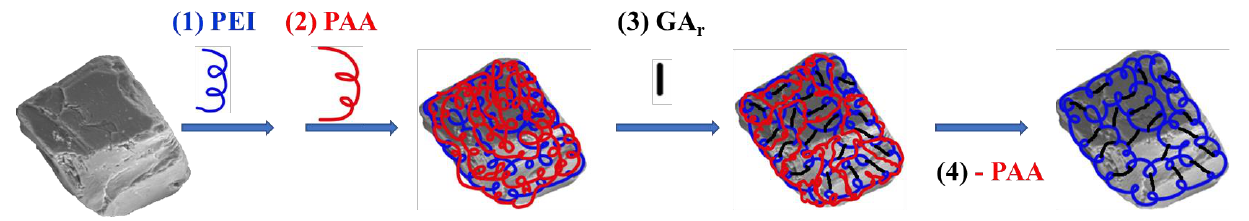
Scheme 1. Schematical representation of sand/PEI-GA r composites by the complex precipitation on sand microparticles and PEI cross-linking with GA (r = [CHO]:[amine] = 1:10, 1:5 and 1:1) and PAA extraction from composite shell.